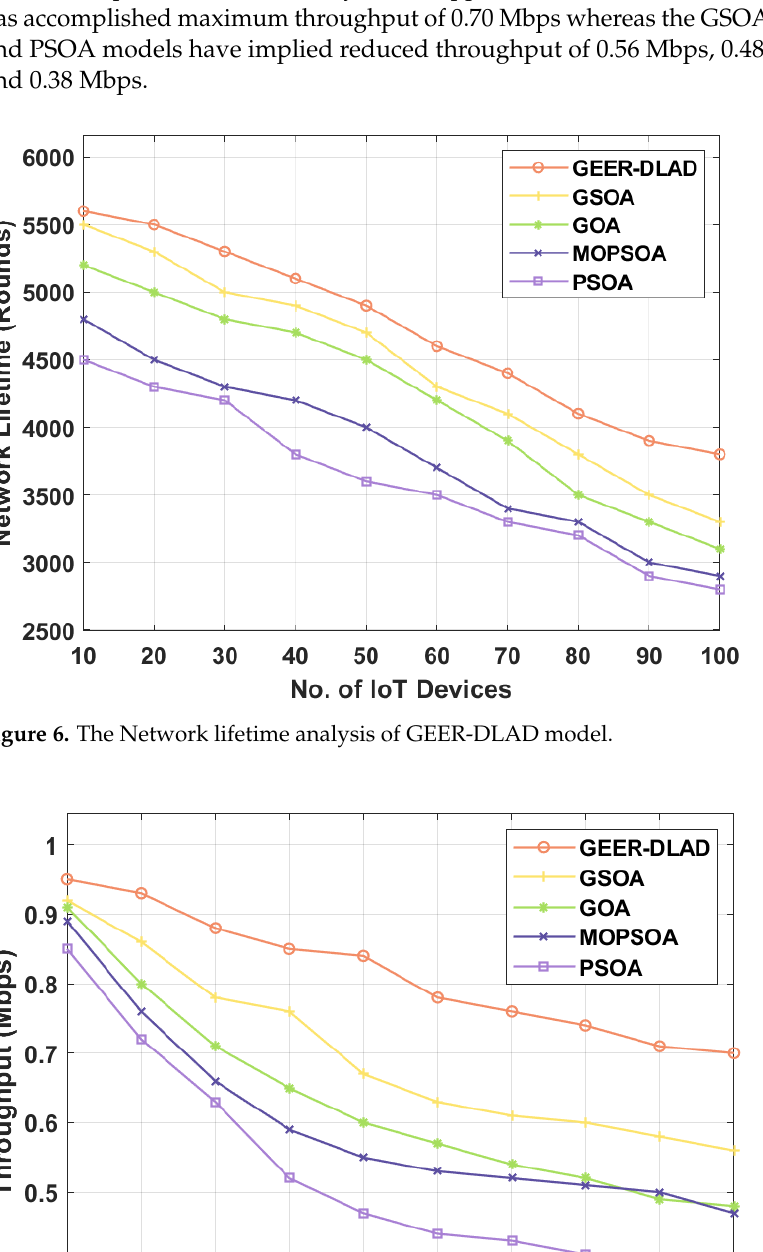
Table 3. The Result Analysis of Existing with Proposed GEER-DLAD Method in terms of Throughput (Mbps).